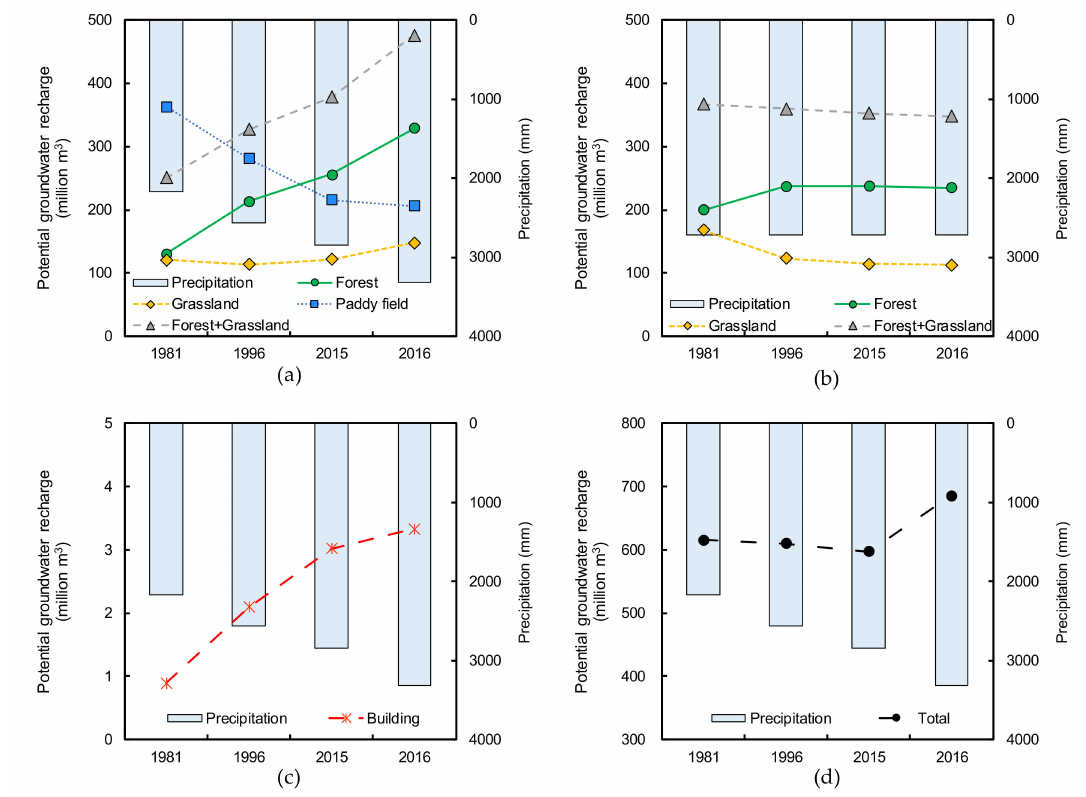
Figure 7. Temporal changes in potential groundwater recharge for Forest, Grassland, Paddy field, and Building: ( a ) actual precipitation, ( b ) constant precipitation, ( c ) actual precipitation, ( d ) actual